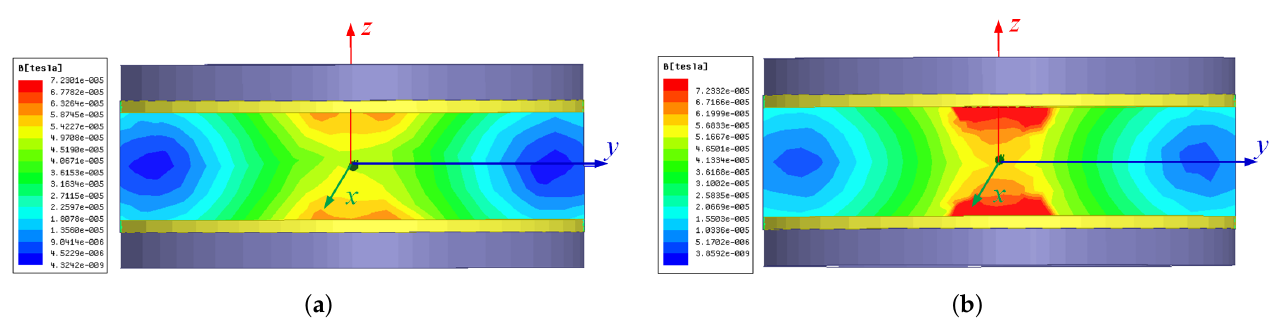
Figure 8. Comparison of two magnetic coupling structures’ magnetic field distribution: ( a ) Magnetic field distribution of planar core; ( b ) Magnetic field distribution of proposed core.